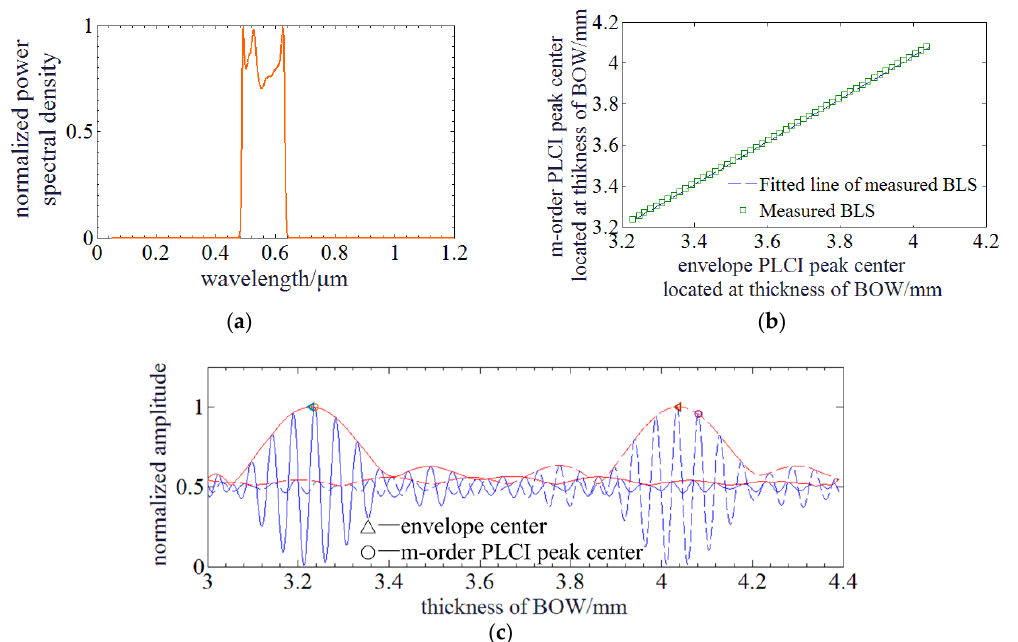
Figure 5. Simulation of PLCI for MADM with a BLS of measured profile: ( a ) The profile of the Gauss BLS; ( b ) Relationship between envelope and zero-order PLCIF peak center; ( c ) PLCIF of BLS in measured profile: The solid and dotted lines represent the PLCIFs at different MDs. The blue and red lines represent the measured PLCIFs achieved by SC and envelopes curves achieved by FFT method.